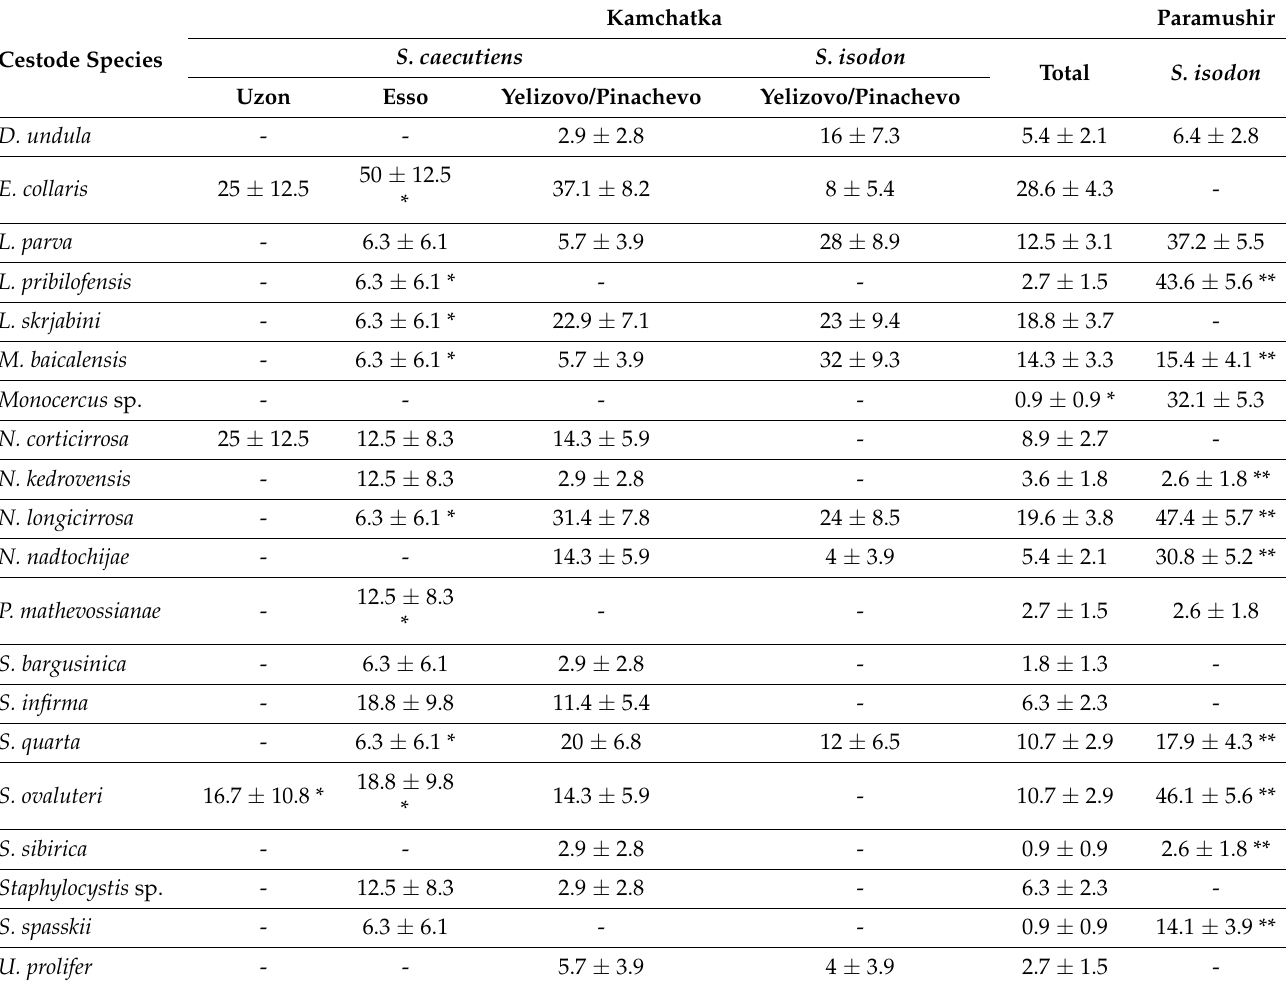
Table 4. Cestode infections of S. caecutiens and S. isodon in Kamchatka and Paramushir (P ± SE, %), *—cestodes found in S. isodon in Kamchatka, **—cestodes found in S. caecutiens on